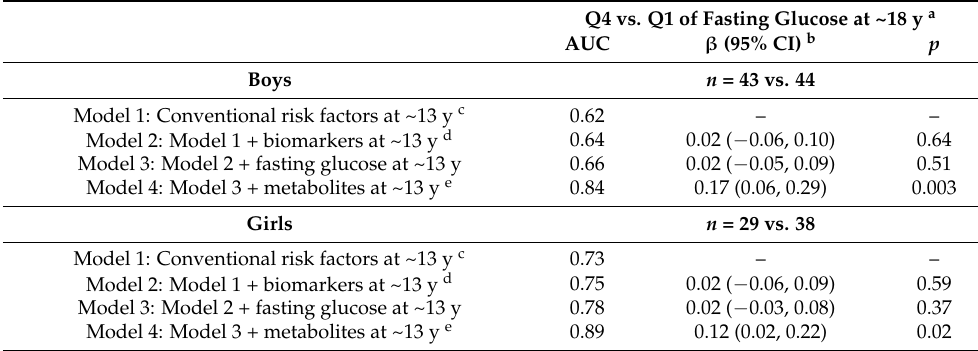
0.88 0.16 (0.07, 0.26) 0.0007 – – a Estimates are a difference in AUC for Model 2 vs. Model 1, Model 3 vs. Model 2, and Model 4 vs. Model 3. b Includes quartiles of age at baseline; difference in age between baseline and follow-up; ethnicity (Hispanic vs. non- Hispanic), BMI z-score, in utero exposure to gestational diabetes, and family history of type 2 diabetes. c Model 1 + waist circumference, fasting insulin, total cholesterol, triglycerides, HDL, and Tanner stage for pubic hair development at baseline. d Model 3 + sex-specific metabolites measured at baseline (shown in Table 3 for boys and Table 4 for girls). e Boys: median glucose for Q1: 4.6 mmol/L and Q4: 5.4 mmol/L; Girls: Q1: 4.8 mmol/L and Q4: 5.0 mmol/L. Table 4. Comparison of area under the receiver operating characteristic curve (AUC) for conventional risk factors vs. metabolites at baseline (age ~13 y) predicting elevated fasting glucose (Q4 vs. Q1) at follow-up (age ~18 y) among youth in Project Viva. Q4 vs. Q1 of Fasting Glucose at ~18 y a AUC β (95% CI) b p Boys n = 43 vs. 44 Model 1: Conventional risk factors at ~13 y c 0.62